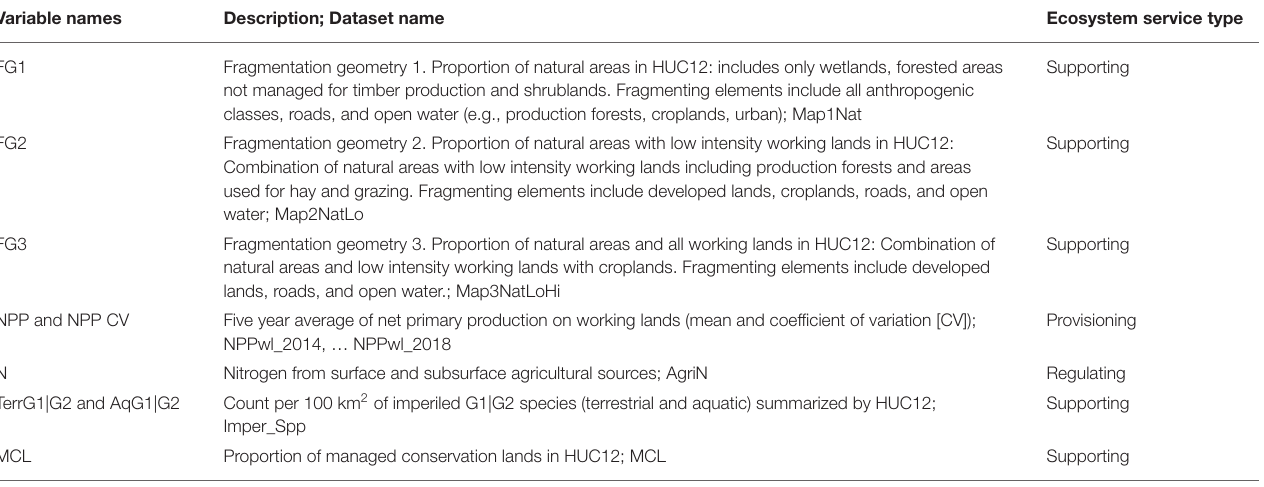
TABLE 1 | Derived datasets used for analysis (see Supplementary Material 1 for sources and land cover reclassification; Supplementary Material 2—Data Table